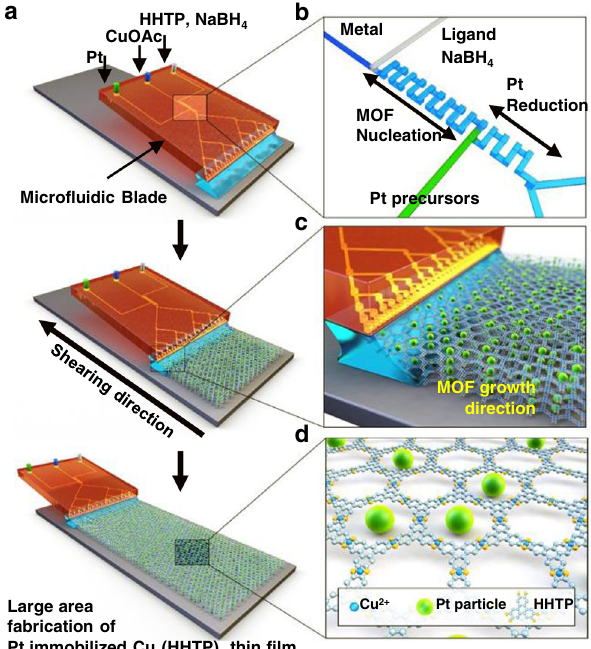
Fig. 1 Fabrication of Pt@Cu 3 (HHTP) 2 thin fi lm using MiCS. a Schematic of Pt@Cu 3 (HHTP) 2 MOF thin- fi lm processing using micro fl uidic-based solution-shearing process. CuOAC is copper(II) acetate. b Schematic illustration of the micro fl uidic blade channel. c Schematic illustration of the MOF growth process using solution shearing. The nucleated Pt particle- embedded MOF solution is located between the micro fl uidic blade and the heated substrate. The MOF growth occurs at the edge of the meniscus. With the continuously supplying solution by the micro fl uidic blade during solution shearing, large-area and uniform Pt@Cu 3 (HHTP) 2 thin fi lm can be formed. d Crystal structure of Pt@Cu 3 (HHTP) 2 thin fi lm (green sphere: Pt particle). @ means